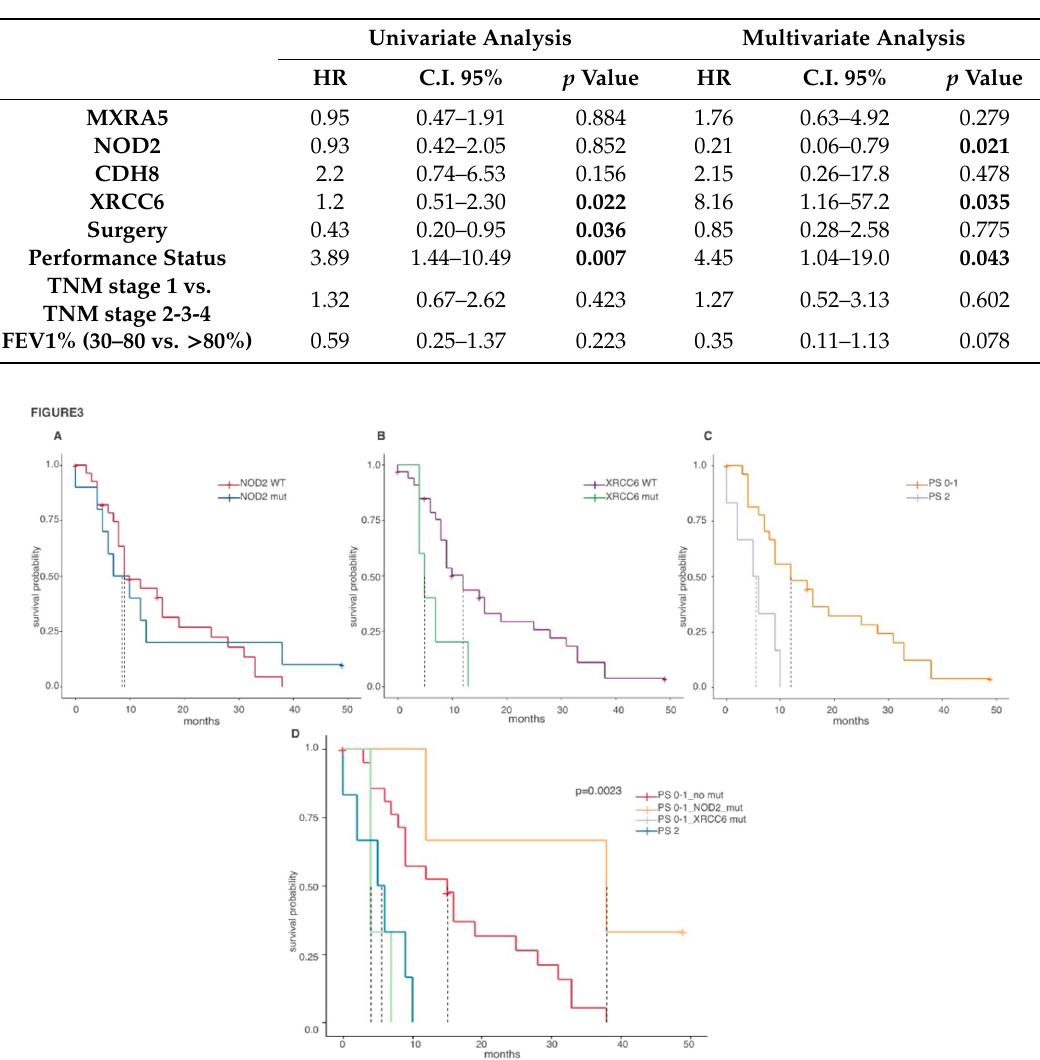
Figure 3. Genetic alterations affect clinical behaviour of biph-MPM independently from performance status. ( A ) Kaplan Meier curves of biph-MPM patients according to NOD2 mutational status. ( B ) Kaplan Meier curves of biph-MPM patients according to XRCC6 mutational status. ( C ) Kaplan Meier curves of biphasic MPM patients according to performance status score. ( D ) Kaplan Meier curves of biphasic MPM patients with different performance and mutational status.